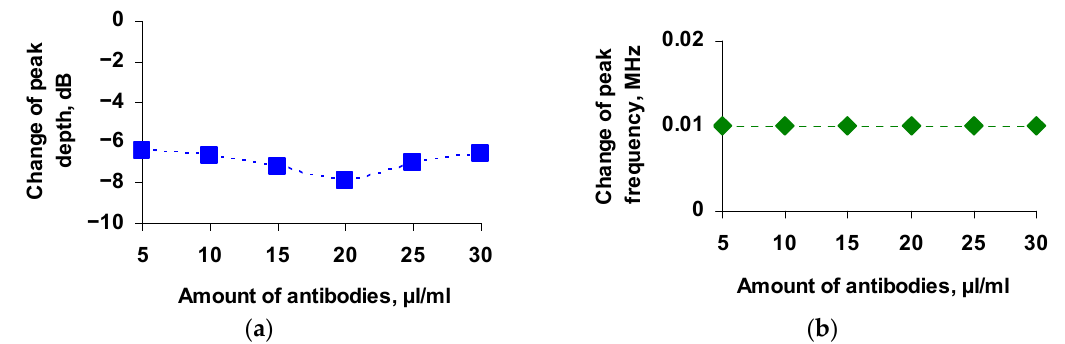
Figure 8. Dependences of the change in the depth ( a ) and frequency ( b ) of the resonance peak near the frequency of 2.82 MHz on the amount of Ab TGEV added to TGE virus.